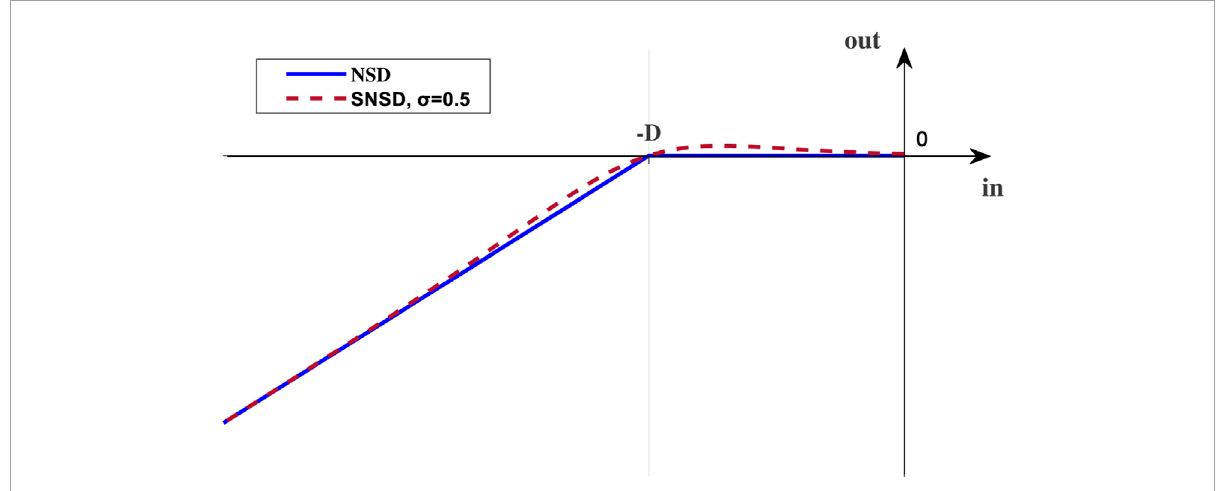
FIGURE 2 Non-step deadband and its